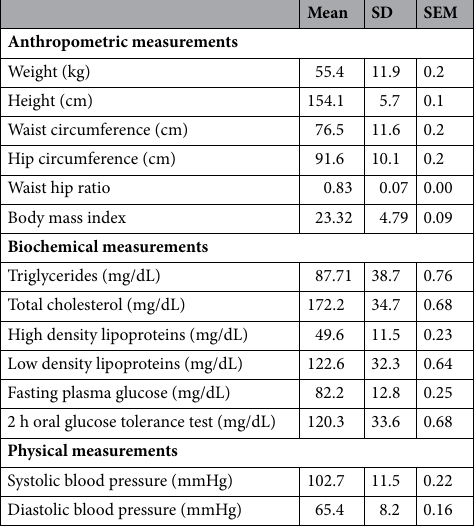
Table 2. Anthropometric data, blood biochemistry and physical measures of 2682 first trimester pregnant women. SD standard deviation, SEM standard error of mean.